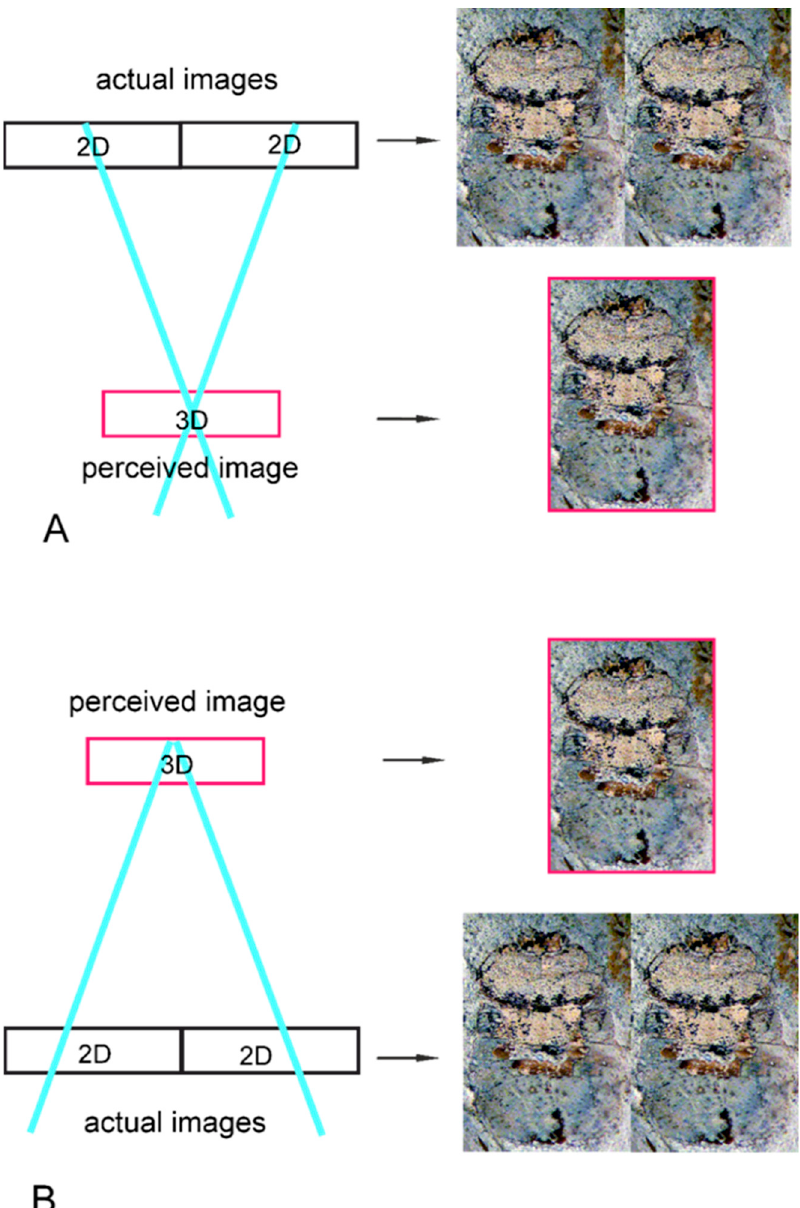
Figure 1. A comparison of the cross-eyed technique ( A ) versus the parallel viewing technique ( B ) for free viewing a stereo pair of images. Blue lines denote the left-eye and right-eye viewing lines.